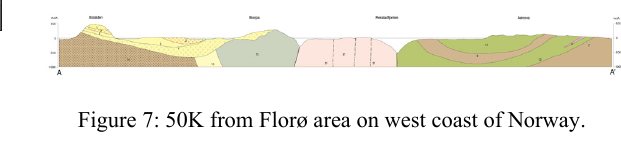
Figure 6: Examples of storing bedrock profiles in database. There is a wide spectrum of quality of the profiles: the 250K profiles tend to be of high quality whereas many of the 50K profiles are poorly constructed and drawn (Figure 8 ).